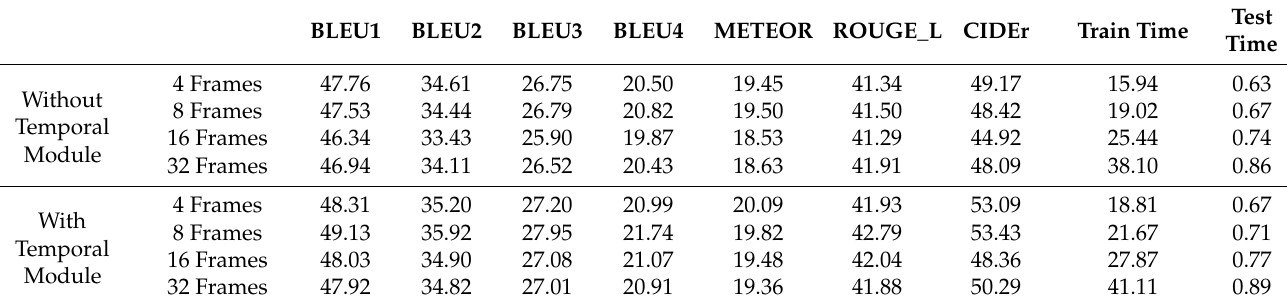
Table 2. Results of the first proposed captioning